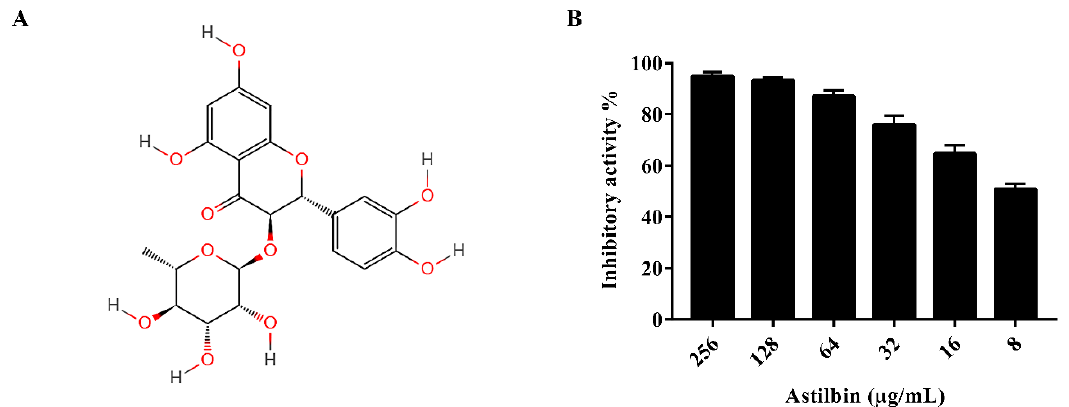
Figure 1. The structure of astilbin and the inhibition of S. mutans SrtA by astilbin in vitro. ( A ) The chemical structure of astilbin. ( B ) The inhibitory effect of astilbin against the SrtA of S. mutans . The purified SrtA was incubated with or without different concentrations of astilbin at 37 ◦ C for 1 h, then the fluorescent substrate peptide was added, and the plate was incubated for 1 h. The fluorescence intensity of each well was measured with an excitation wavelength of 350 nm and an emission wavelength of 495 nm. The values indicate the mean values of three independent experiments. The error bars represent the standard deviations.